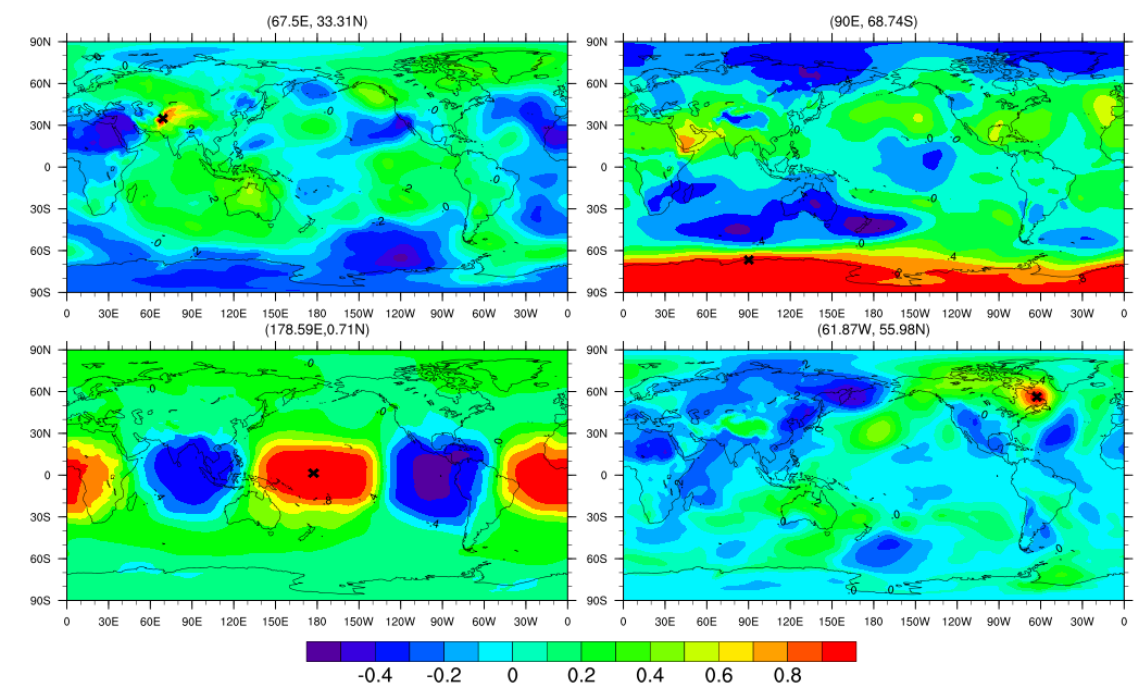
Figure 8. The historical horizontal correlation of the model integration results at four locations.